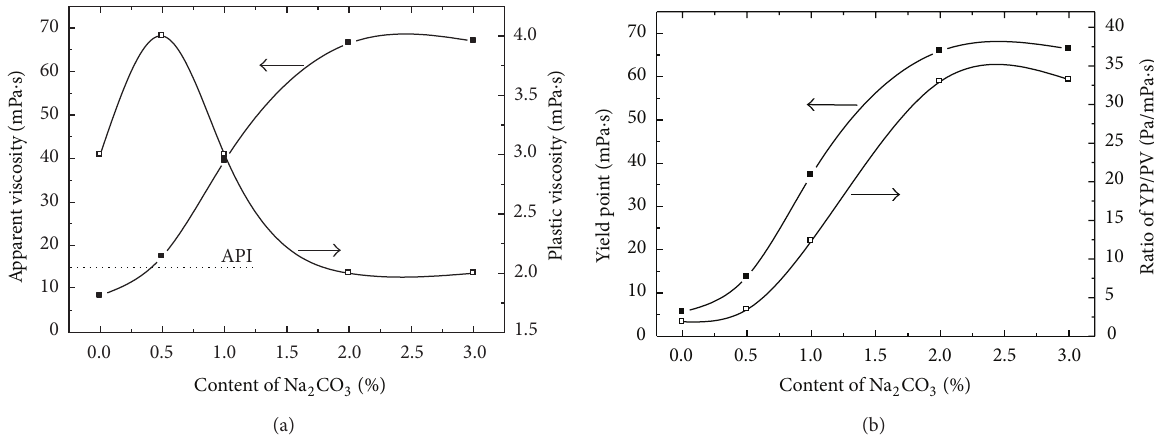
Figure 4: The viscosity of a natural coexisting clay mixture sample with 7% palygorskite and 57% sodium-calcium based hybrid bentonite from Iraq Anbar. (a) The apparent viscosity and plastic viscosity of the natural coexisting clay mixture. (b) The yield point and ratio of YP/PV of the natural coexisting clay